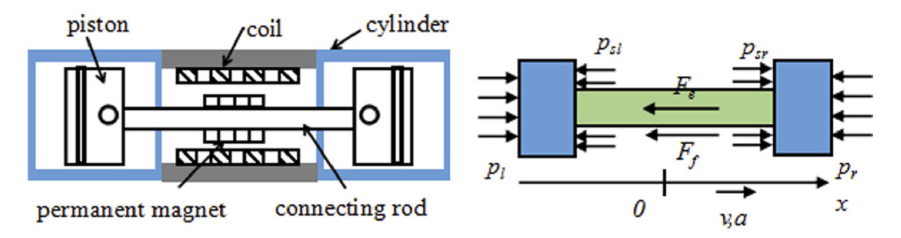
Figure 3. Free piston engine–generator (FPEG) assembly ( left ) with forces acting on its piston shown ( right )